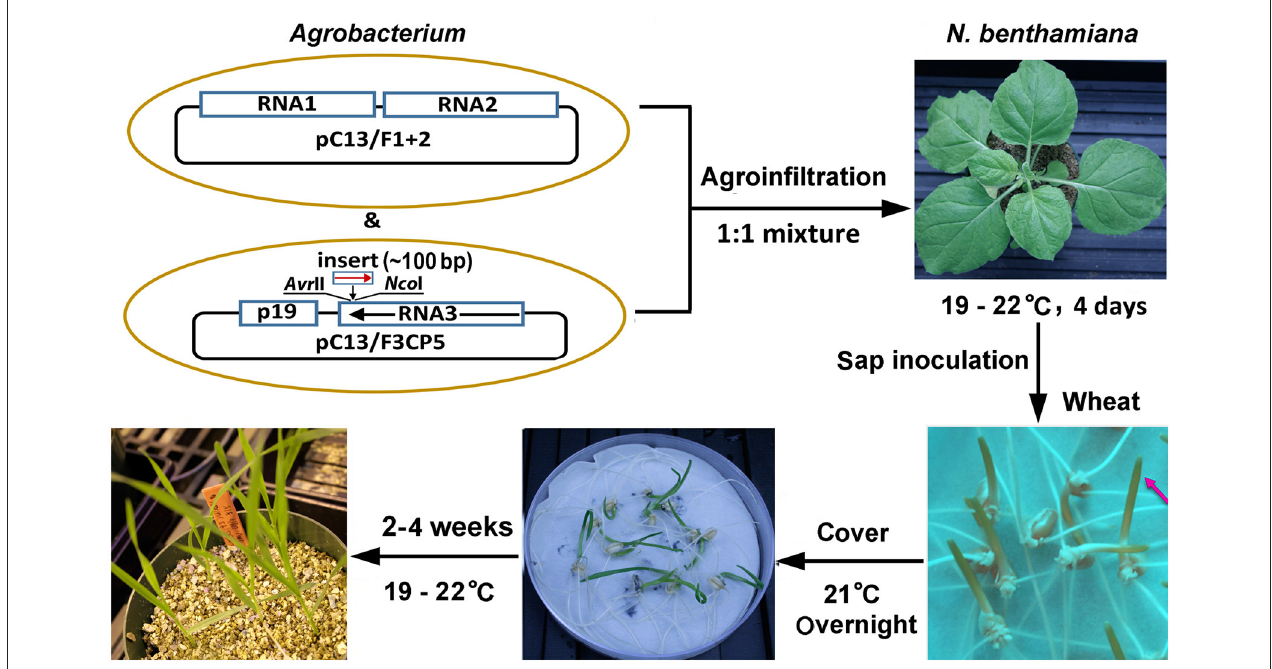
FIGURE 1 | Protocol for BMVCP5-mediated gene silencing in wheat. Binary vectors pC13/F1 + 2 and pC13/F3CP5 contain sequences allowing expression of RNAs 1 and 2 and RNA 3, respectively, of the BMVCP5 silencing vector. For VIGS, a host gene fragment, optimally of ∼ 100-bp, is inserted into the Nco I and Avr II sites in RNA3 sequence of pC13/F3CP5 in an antisense orientation. Agrobacterium containing the binary vectors with BMVCP5 are infiltrated into Nicotiana benthamiana leaves for multiplication of the viral silencing vector. N. benthamiana leaves are harvested at 4 days post infiltration, and crude sap is prepared for mechanical (rub) inoculation to wheat coleoptiles at 3 days post germination (or wheat leaves at 7–9 days post germination). Red arrow points to coleoptile for inoculation. Inoculated wheat seedlings are covered, kept at room temperature (21 ◦ C) overnight, and then transferred to solid media (or a hydroponic growth system) and grown in a greenhouse at 19–22 ◦ C for 2–4 weeks for target gene